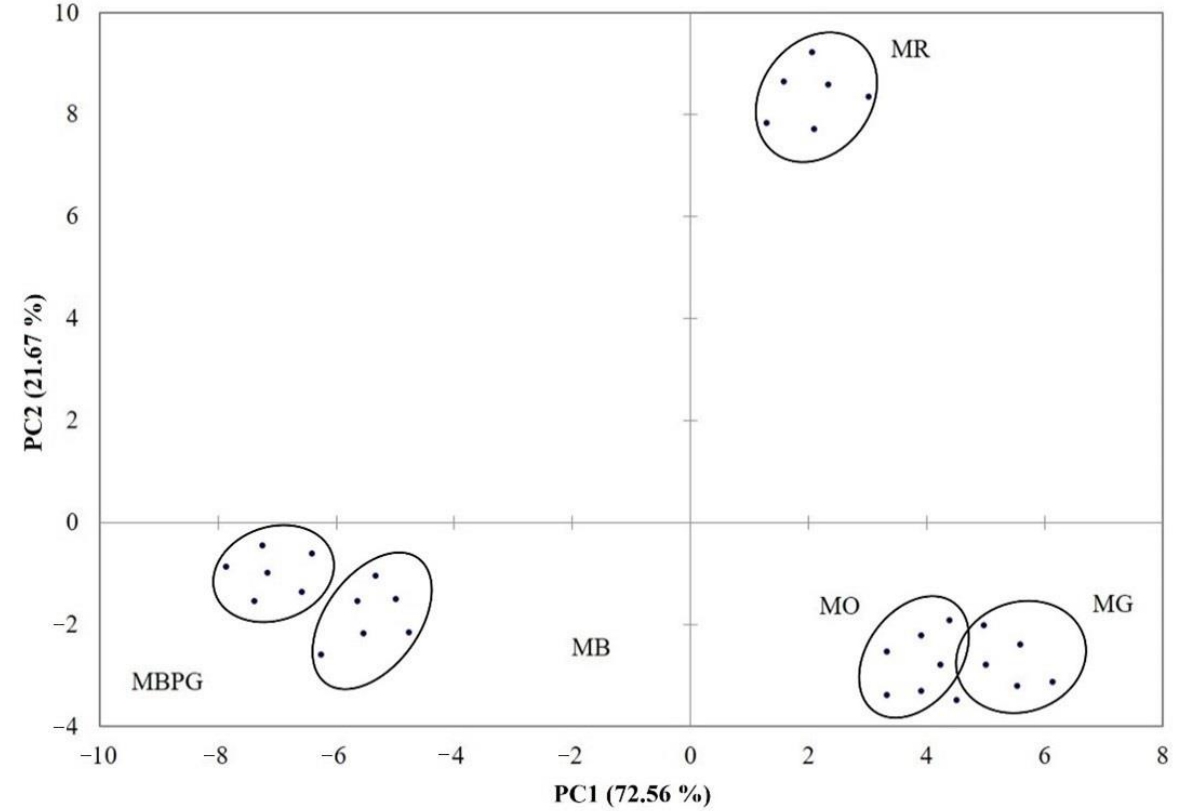
Figure 3. Principal component analysis (PCA) plot showing the multivariate variation among the fortified Moscato wines from different varieties in terms of volatile aroma compounds. MG = Moscato Giallo; MB = Moscato Bianco; MBPG = Moscato Bianco at Petit Grain; MO = Moscato Ottonel; MR = Moscato Rosa.